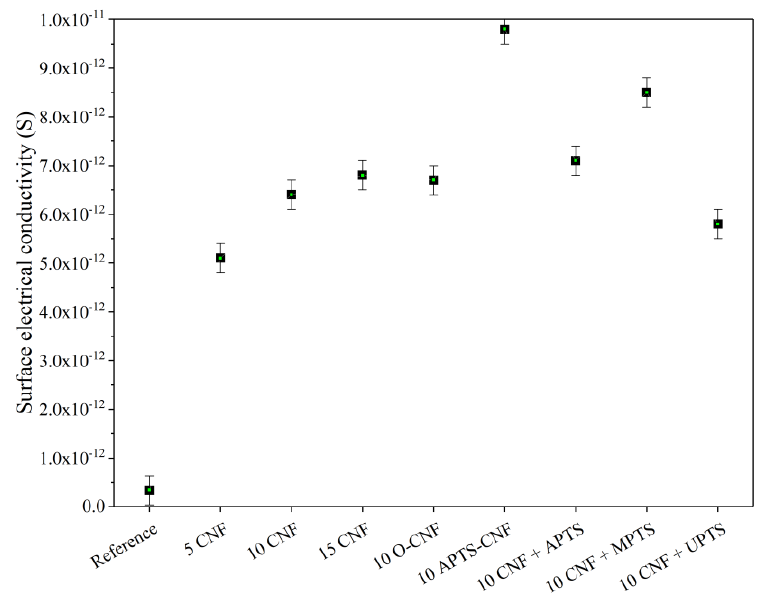
Figure 14. Surface electrical conductivity of NBR composites filled with modified carbon nanofibers.